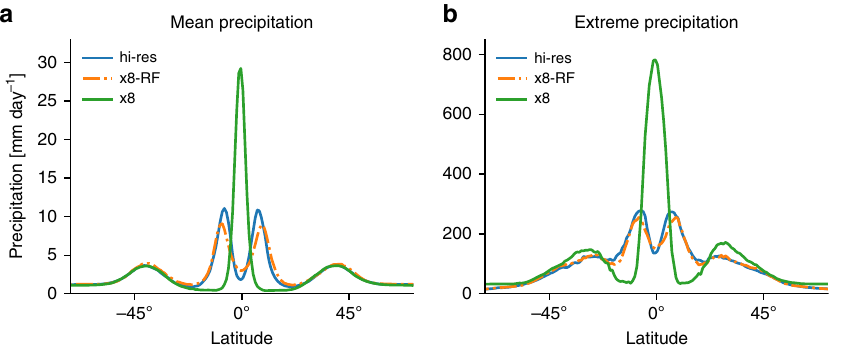
Fig. 2 Mean and extreme precipitation as a function of latitude. a Zonal- and time-mean precipitation and b 99.9th percentile of 3-hourly precipitation, for the high-resolution simulation (hi-res; blue), and the coarse resolution simulation with the random forest (RF) parameterization (x8-RF; orange dashed – dotted) and without the RF parameterization (x8; green). For hi-res, the precipitation is coarse-grained to the grid spacing of x8 prior to calculating the 99.9th percentile to give a fair comparison 41